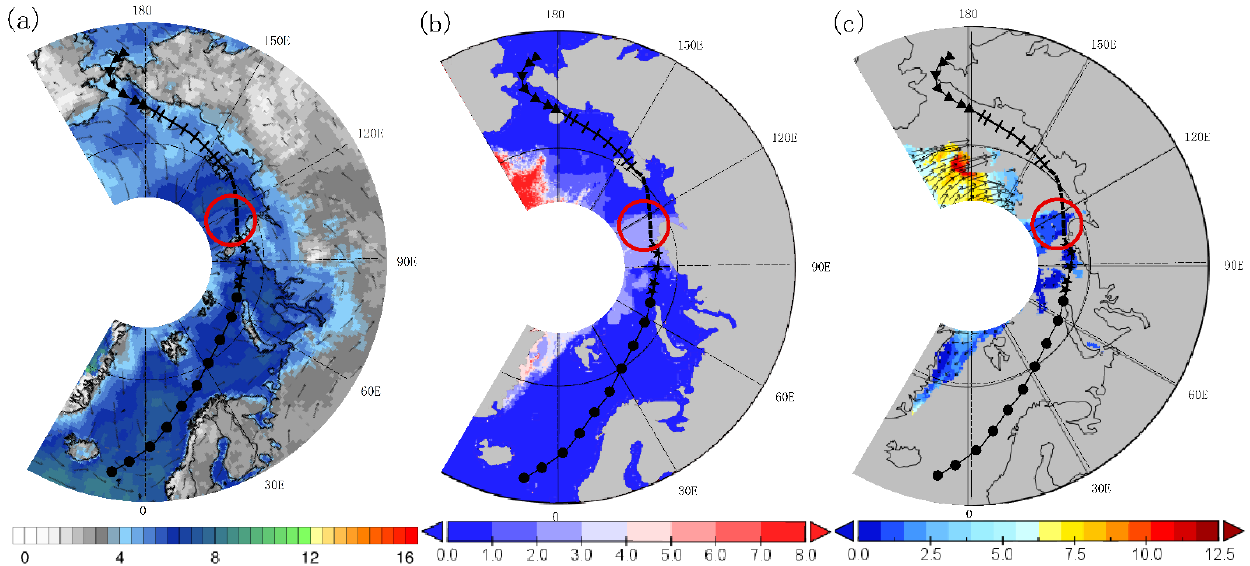
Figure 15. The average wind field ( a ), sea ice age ( b ) and sea ice movement ( c ) of the NEP in the Arctic in August 2007.